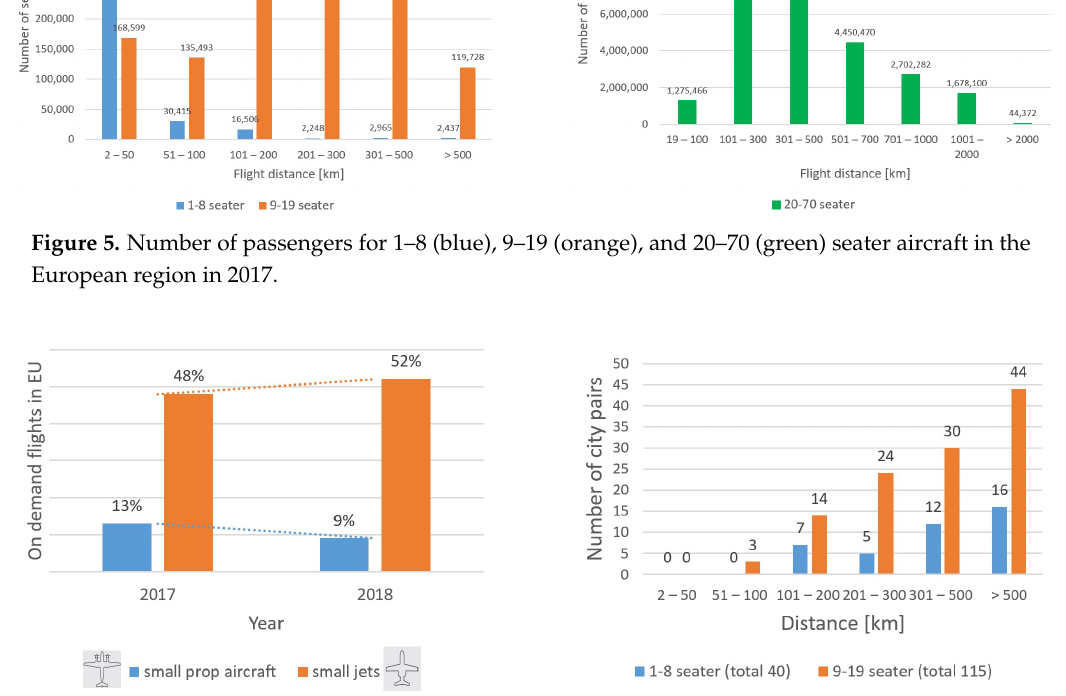
Figure 6. Share in on-demand flights for turboprop (blue) and small jets (orange) for 2017–2018 in the EU [34]. Number of city pairs covered with 1–8 and 9–19 seater aircraft, by distance